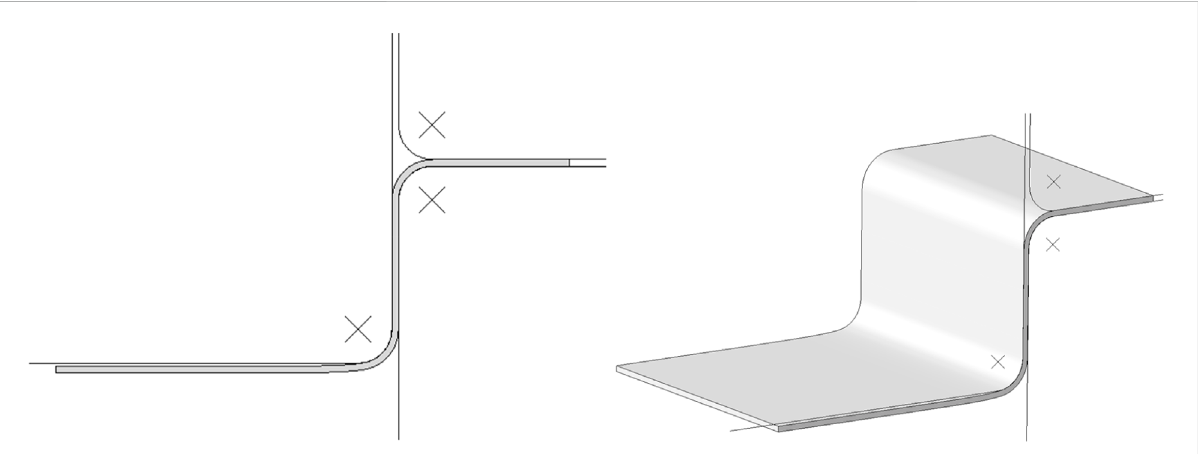
Deformed shape from FE simulation.